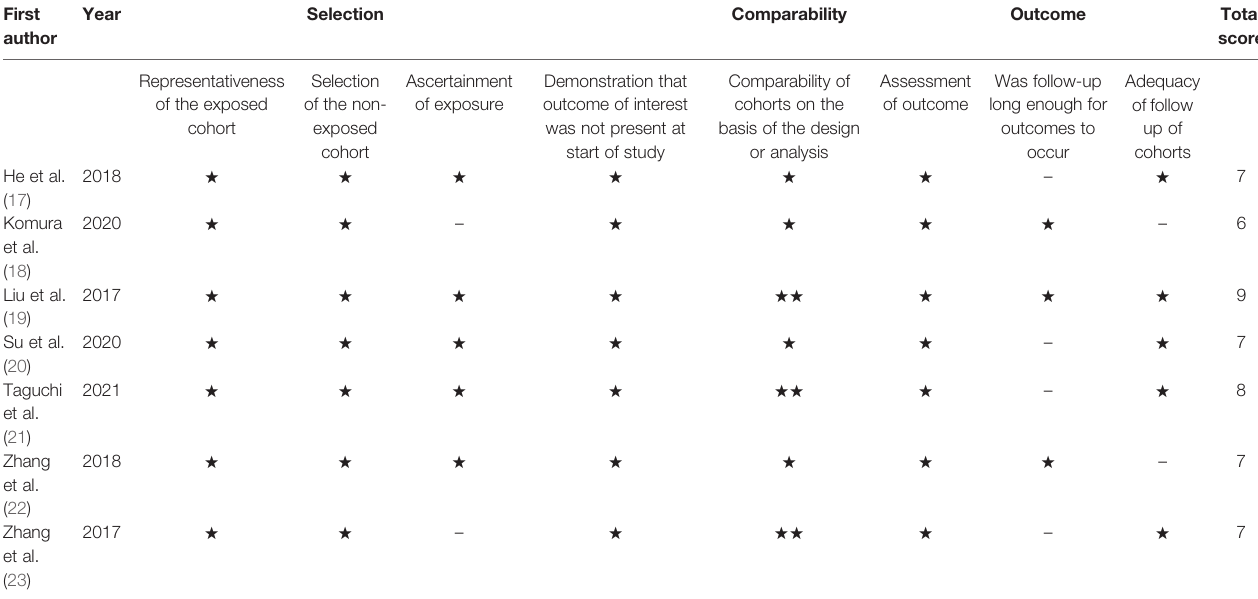
TABLE 2 | The details of NOS scale for studies in the